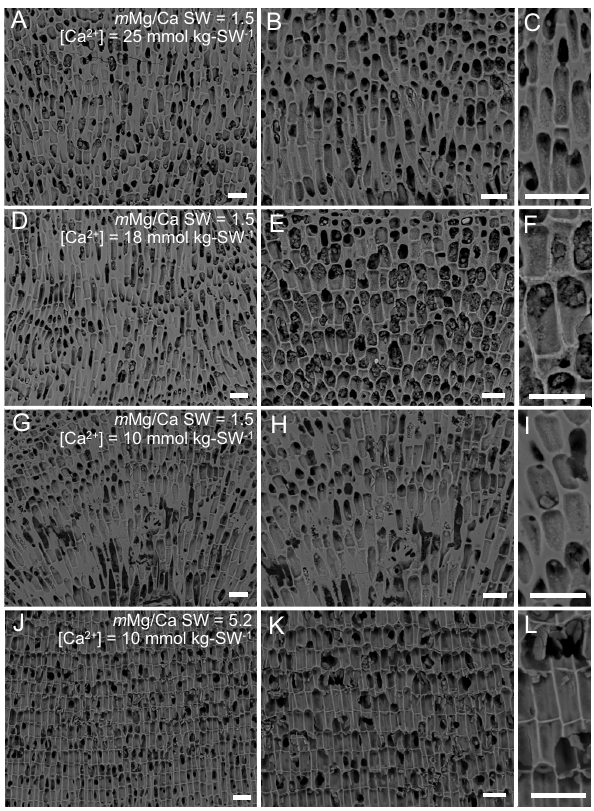
Fig. 23. Backscatter electron images of specimens of the encrust- ing coralline alga Neogoniolithon sp. reared in experimental seawa- ters with Mg/Ca ratios and absolute Ca 2 + concentrations (mmolkg- SW − 1 ) , respectively, of 1.5 and 25 (A–C) , 1.5 and 18 (D–F) , 1.5 and 10 (G–I) , and 5.2 and 10 (equivalent to modern seawater, J– L ). Specimens reared in the low Mg/Ca seawaters (1.5, A–I), which favor the algae’s inherently calcitic skeletal mineral, produced an apparently more heavily calcified and less organized skeleton than did specimens reared in the modern, high Mg/Ca seawater, which naturally favors the precipitation of aragonite. Changes in the ab- solute concentration of Ca 2 + , for specimens reared in experimental seawaters with Mg/Ca ratios fixed at 1.5 (A–I), appear to have little effect on skeletal thickness and organization, suggesting that, for the range of values evaluated in this study, the ambient Mg/Ca ratio is more important than the CaCO 3 saturation state of seawater in influencing rates of algal calcification. Scale bar is 20µm. From Ries (2006b).